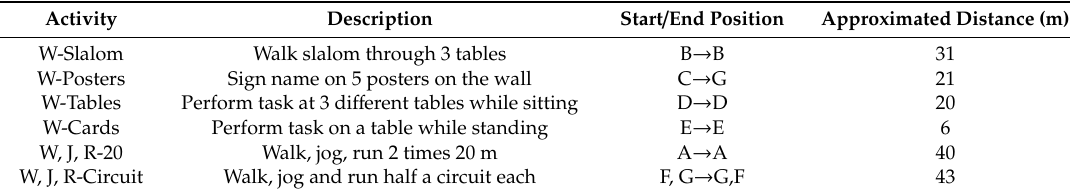
Table 1. Activity descriptions and abbreviations, shown with their relevant start and end points as labeled in Figure 3 as well as approximated distances.